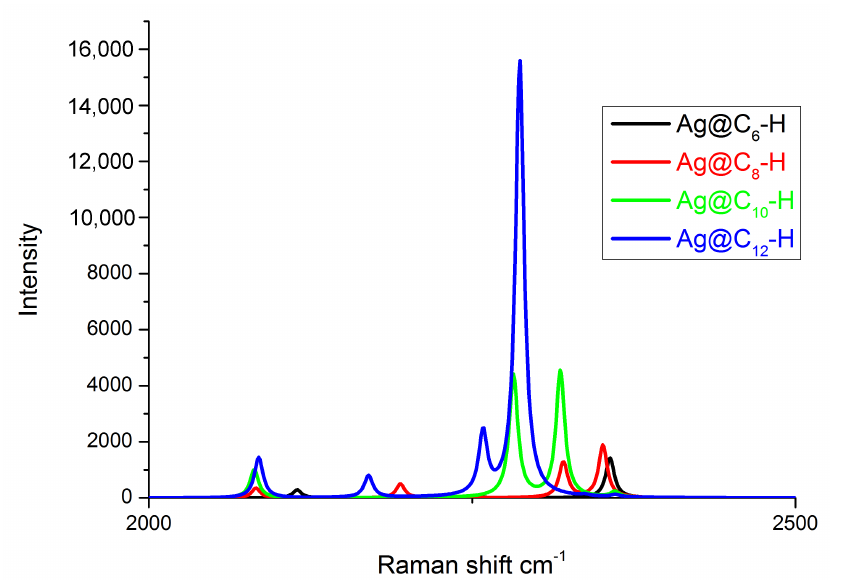
Figure 7. CalculatedRamanspectraofAg@C 2 n –H,3 ≤ n ≤ 6attheMO62X/6-311+G(d,p)/LANL2DZlevel. Within the limits of the method, the calculated UV–Vis spectra, reported in Figure 8, were in agreement with the experimental data.